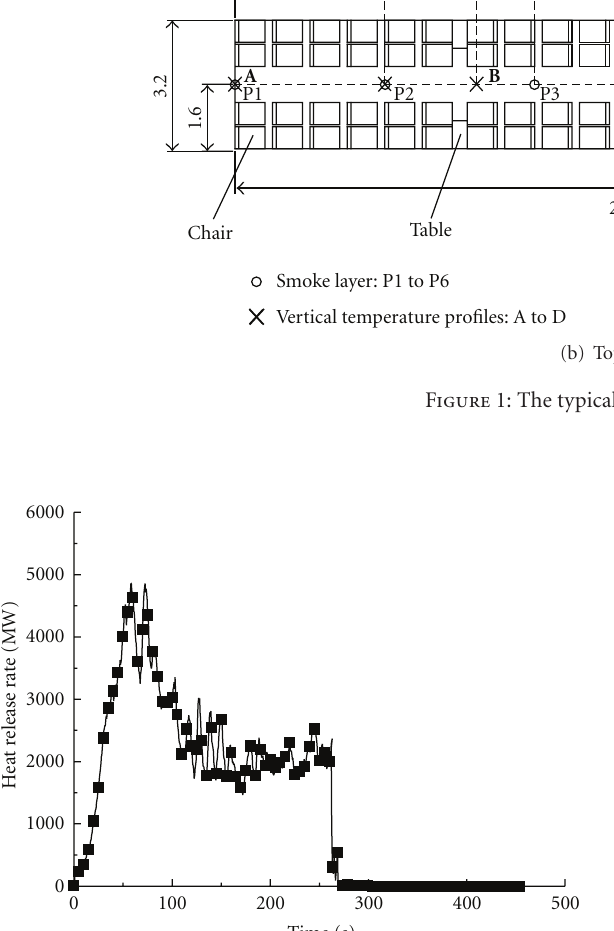
Ignition source